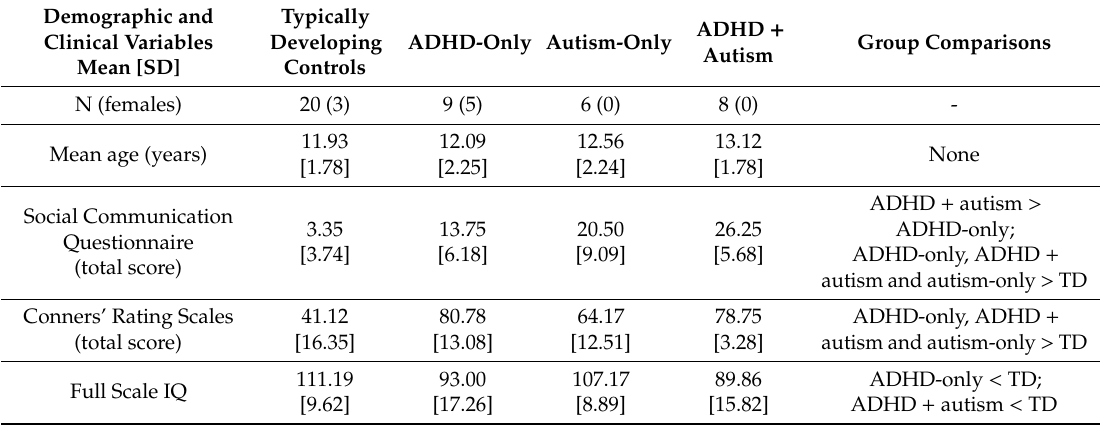
Table 1. Socio-demographic and clinical characteristics of the sample included in the present